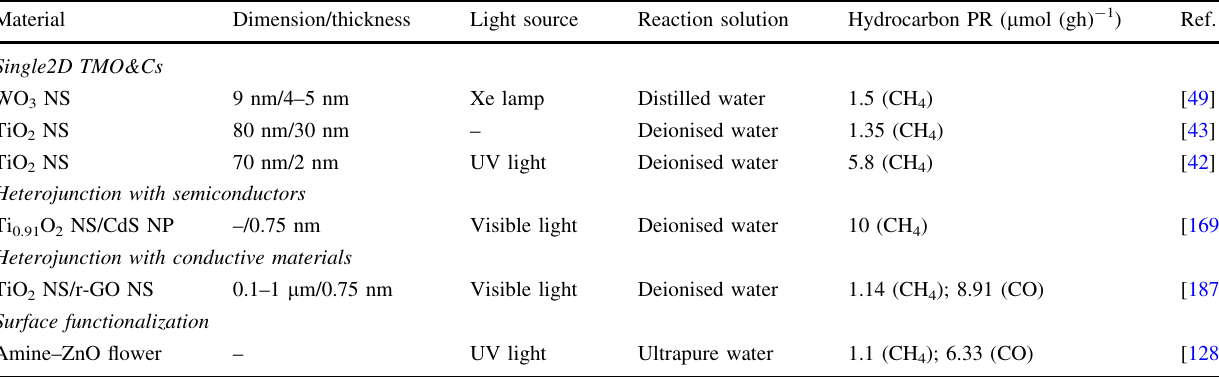
Table 3 Summary of carbon reduction performances of 2D TMO&Cs and their composites